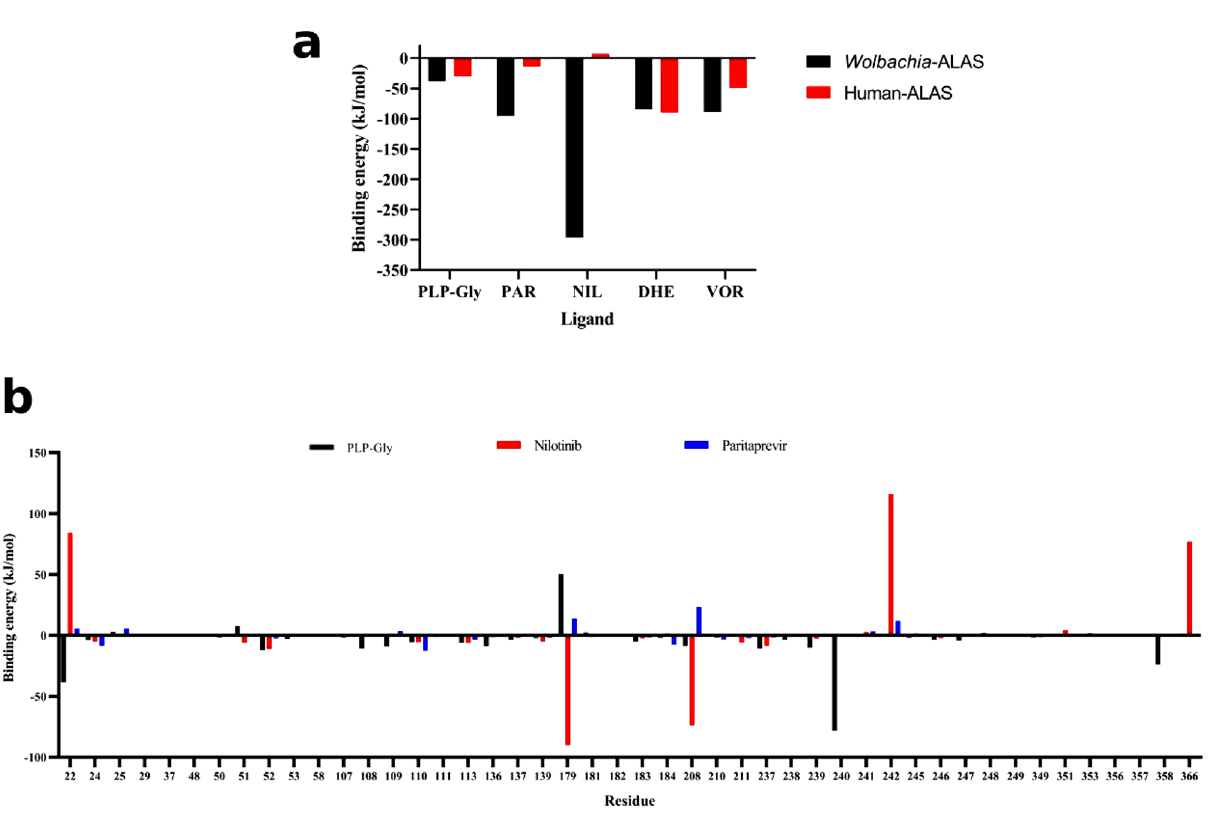
Figure 7. Evaluation of ligand binding energies. ( a ) Comparison of ligand binding energies towards the w ALAS and hALAS. NIL = nilotinib, VOR = vorapaxar, PAR = paritaprevir, DHE = dihydroergotamine ( b ) Residual decomposition of binding energy toward the top candidates and